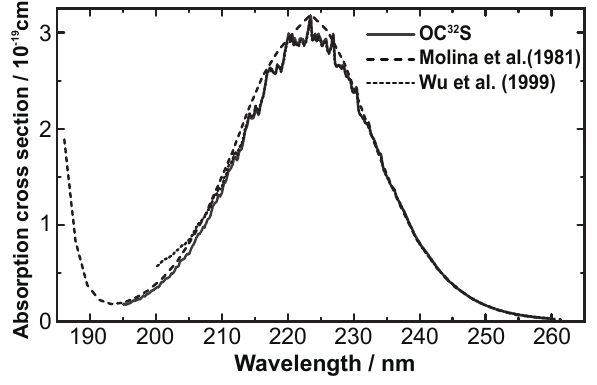
Fig. 1. Measured absorption cross section of the OC 32 S isotopo- logue compared to the spectra of natural isotopic abundance sam- ples measured by Molina et al. (1981) (long dashed line) and Wu et al. (1999) (short dashed line) in the region of 190–260nm.